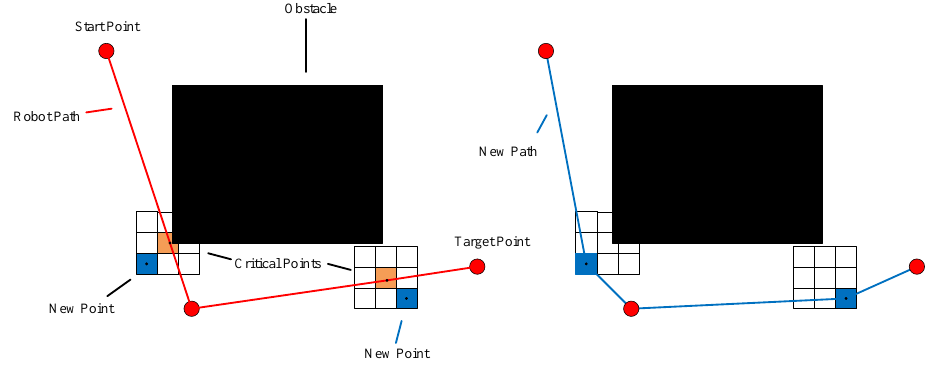
Figure 7. The safety operator is shown. In the left sub-figure, the critical point (indicated by a yellow circle) of each line segment on the path can be replaced by a point with a larger safe distance near the critical point. The sub-figure on the right shows the generated path.